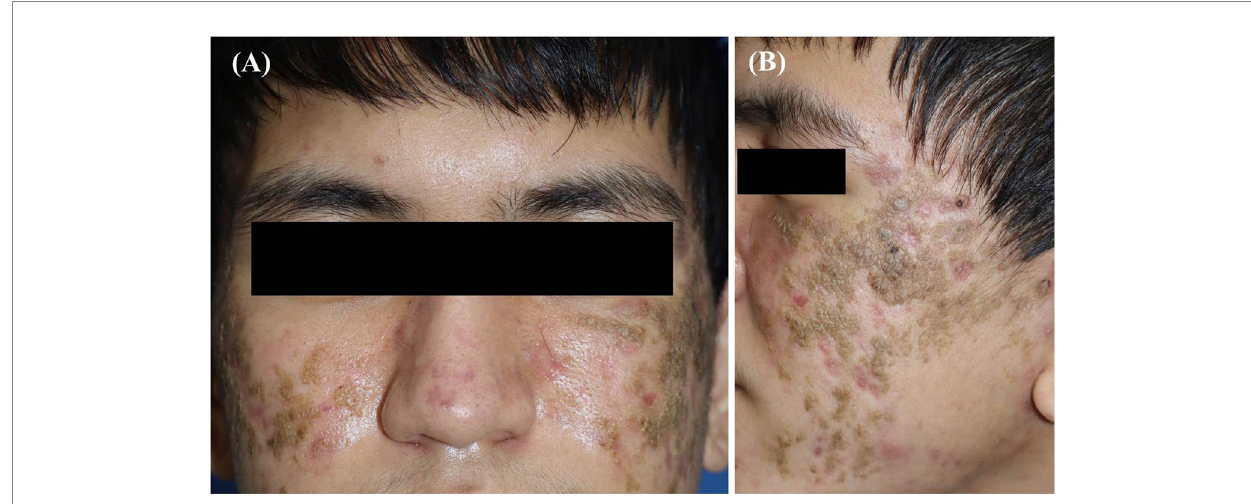
FIGURE 1 (A, B) Multiple well-defined yellowish-to-brownish crusted plaques with a verrucous surface on erythematous-based skin distributed on both